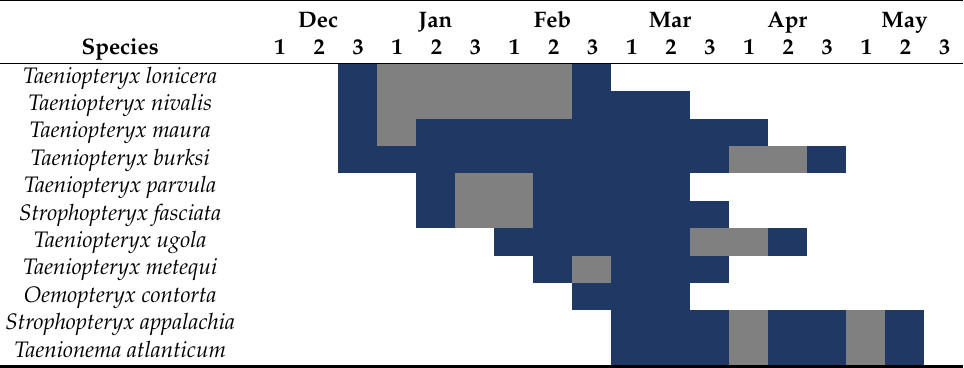
Figure 15. Elevation boxplots for Taeniopteryigidae species recorded from Maryland. Boxes represent the interquartile range, while vertical lines extend to the minimum and maximum values. The horizontal line within the interquartile range represents the median elevation. Outliers are shown with large, solid circles. Small, individual points overlaid on each boxplot illustrate the distribution of observations. Table 12. Recorded adult Taeniopterygidae presence in Maryland. Months are broken into three 10-day periods. Dark blue squares represent periods with collections. Gray squares represent periods when species may be